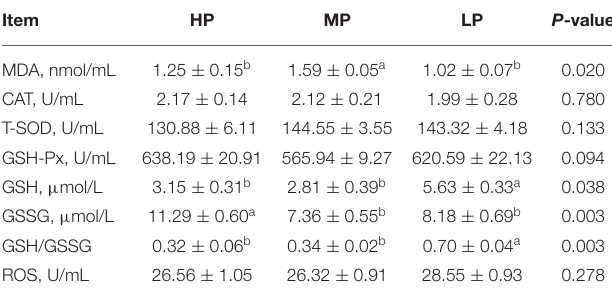
TABLE 7 | Effect of low protein diet on the p antioxidant capacity in finishing